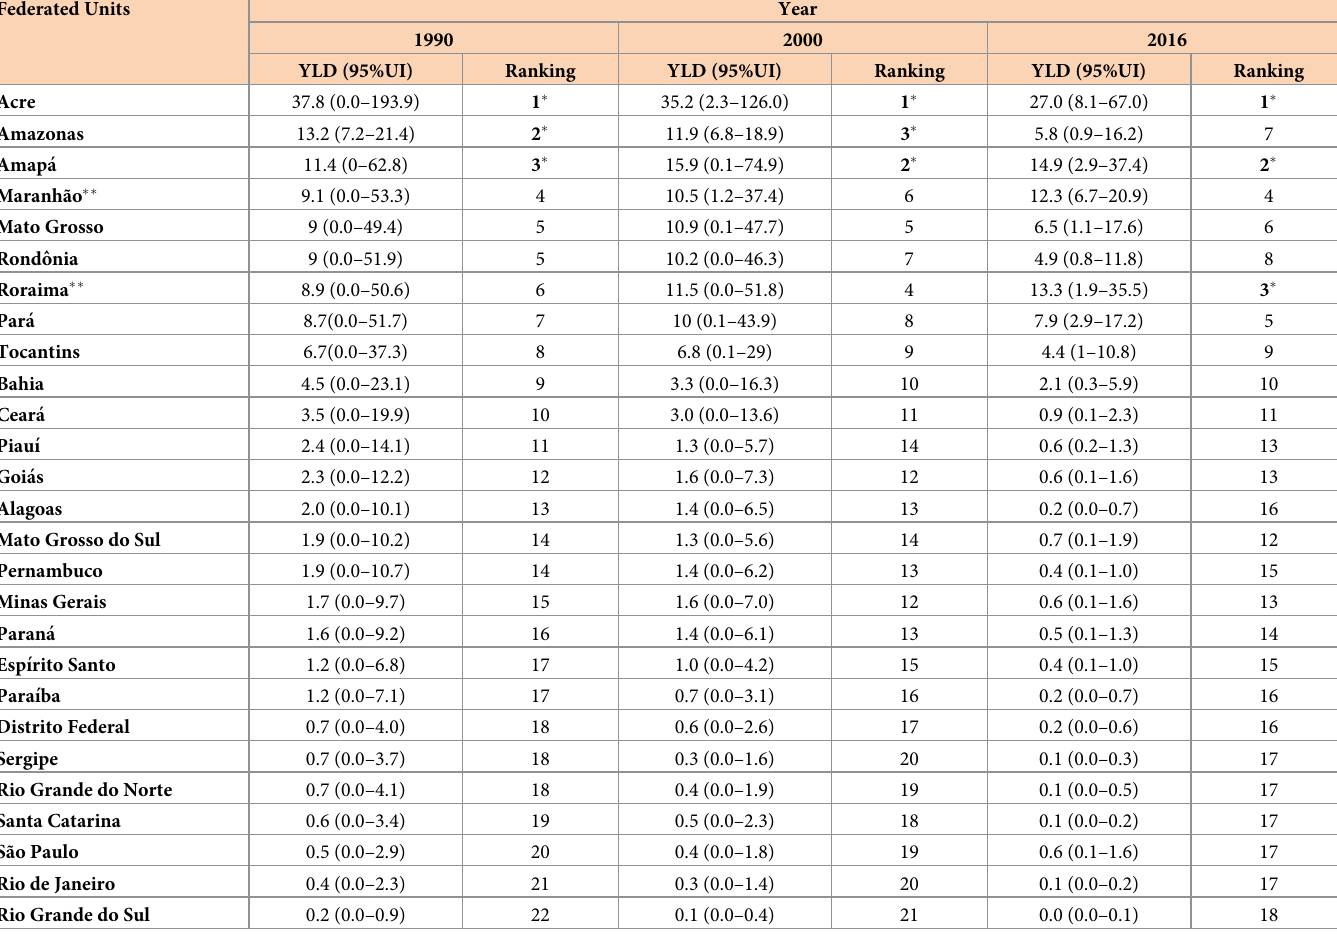
Table 3. Age-standardized rates of years lived with disability (YLD), per 100,000 inhabitants, for Cutaneous and Mucocutaneous Leishmaniasis and relative change in the Brazilian federated units between 1990 and 2016, GBD Study 2016. Federated